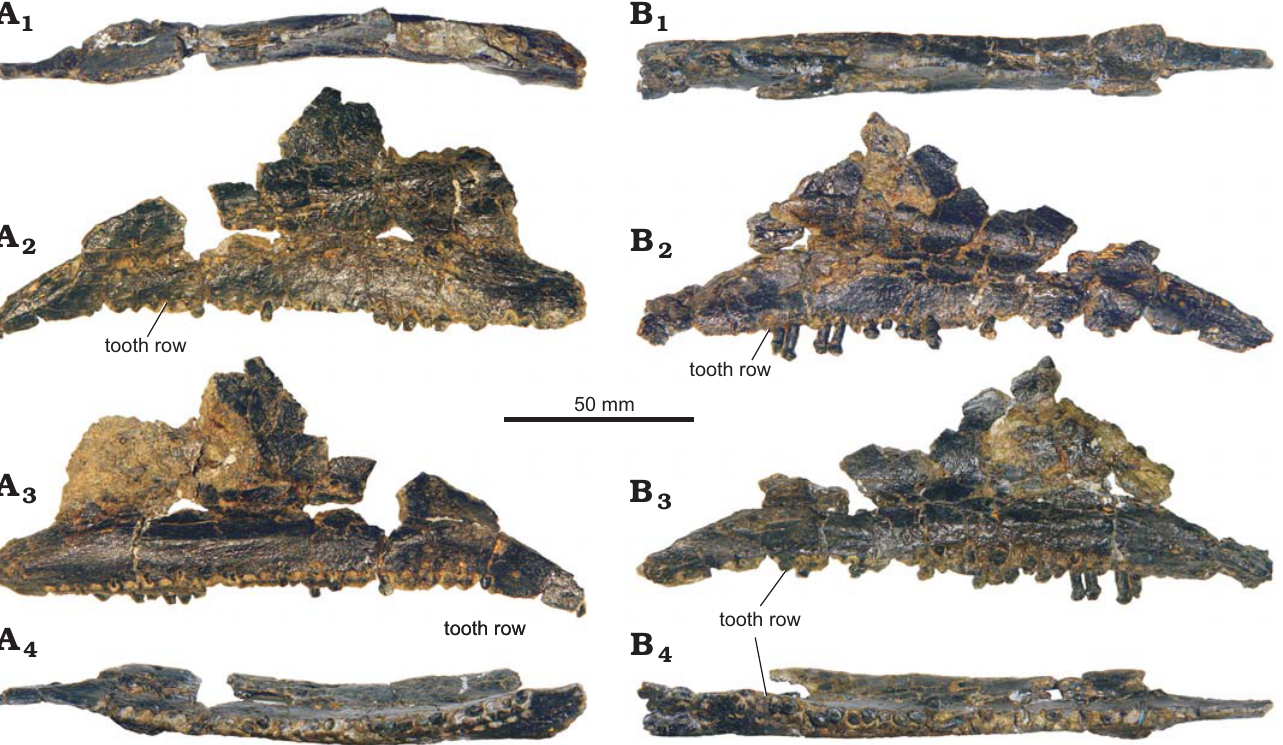
Fig. 8. Stegosaur GPDM 178, near Giffen, Cascade County, Montana. A . Left maxilla in dorsal (A 1 ), lateral (A 2 ), medial (A 3 ), and ventral (A 4 ) views. B . Right maxilla in dorsal (B 1 ), lateral (B 2 ), medial (B 3 ), and ventral (B 4 )